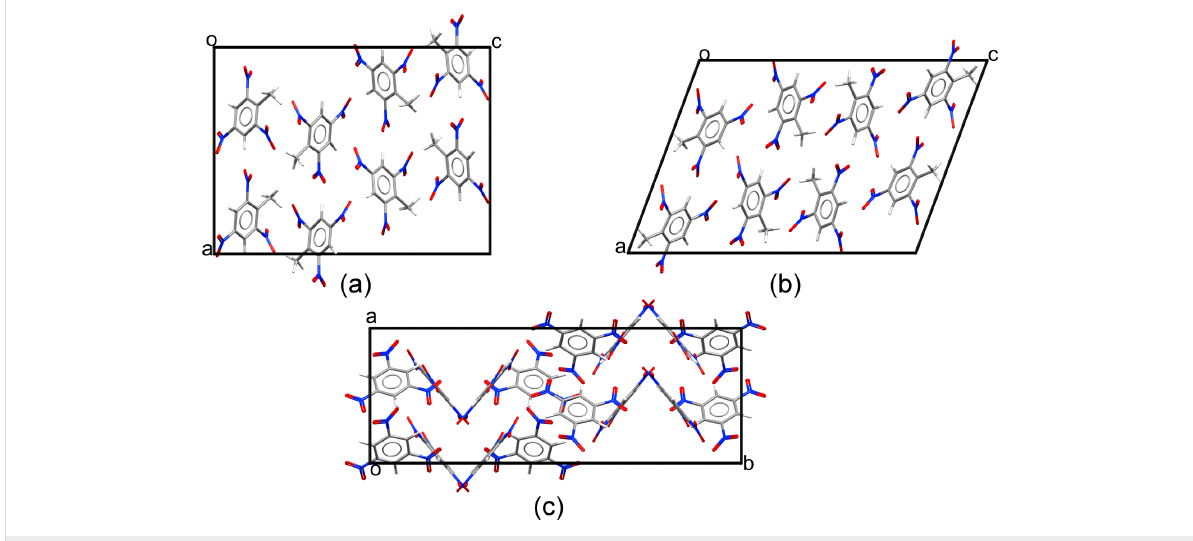
Figure 1: Structures of: (a) orthorhombic TNT, (b) monoclinic TNT, (c) orthorhombic TNB. For each structure, the direction of two of the three lattice vectors ( a , b , c ) is shown in the figure and the third one points inwards at the origin ( o ).